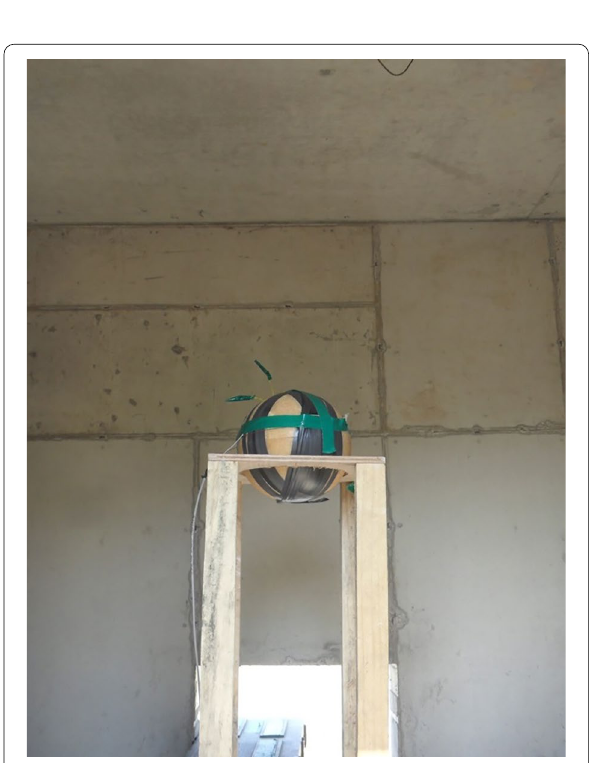
Fig. 2 Shape of the mounted